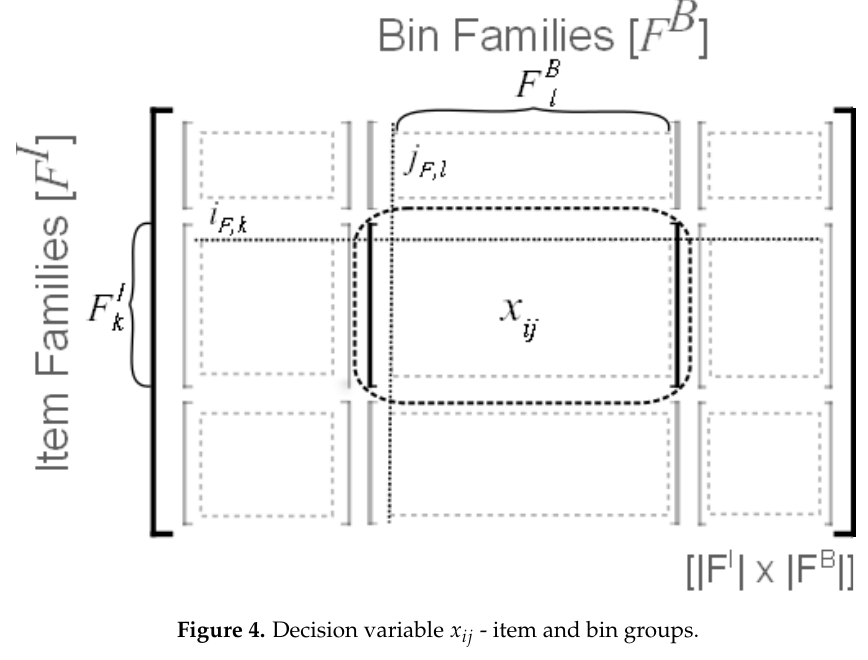
∈ F B ∈ F B , F I and F I . 2 3 2 1 1